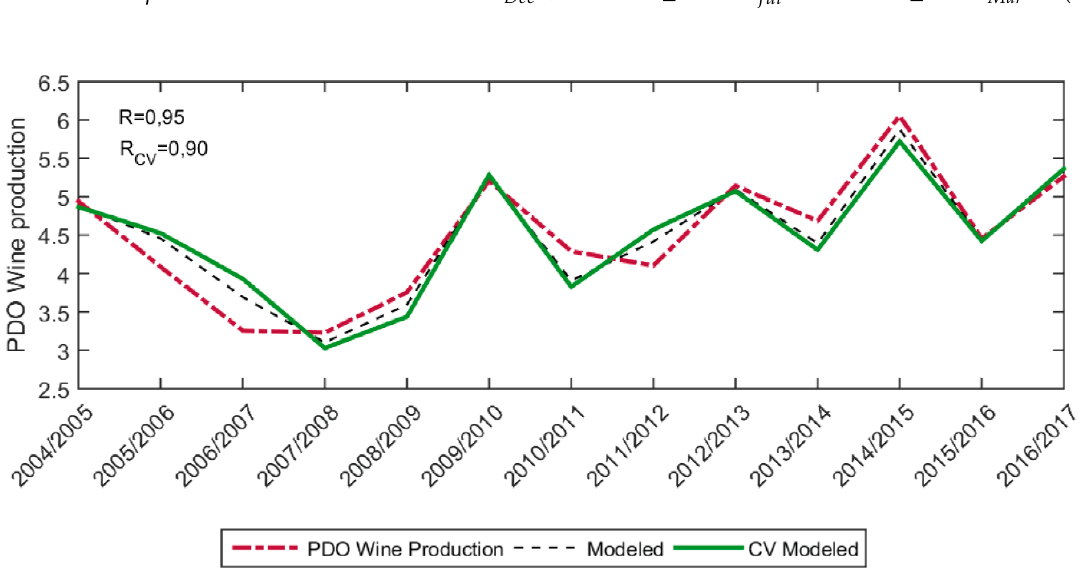
Table 1 . p-values and F-statistics of the predictors selected with the stepwise regression modelling approach.